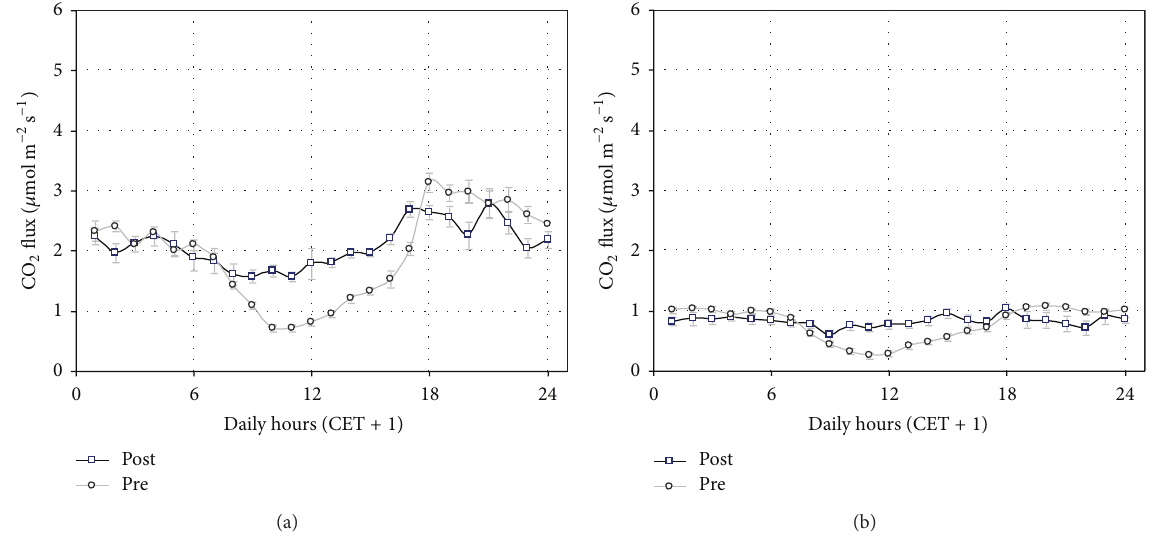
Figure 7: Effect of the application of a herbicide at the NT site (a) and at the CT site (b). Pretreatment and posttreatment hourly mean values are presented, based on measurements recorded 3 days before and 3 days after the herbicide treatment. Vertical bars indicate the standard errors of the means. (CT = conventional tillage site; NT = no-tillage